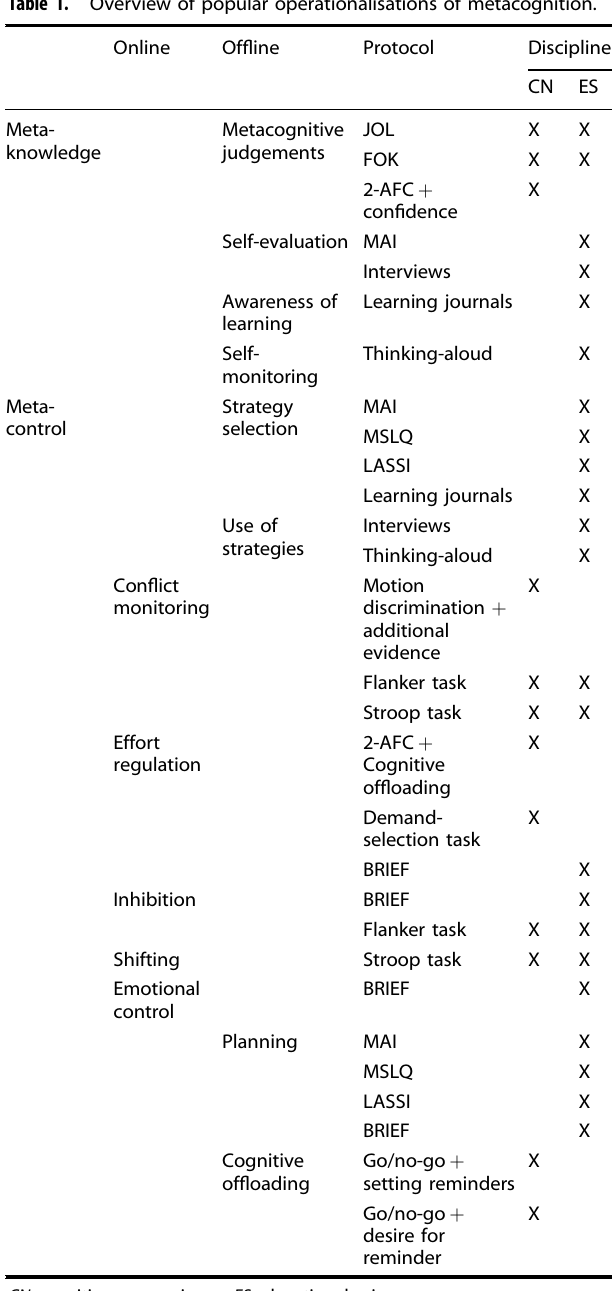
Table 1. Overview of popular operationalisations of